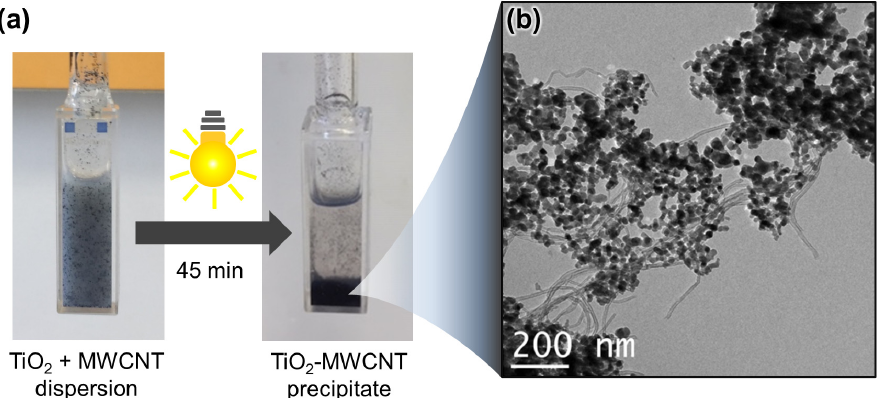
Figure 1. ( a ) Photoreactor before (left) and after (right) exposure to light; ( b ) TEM picture of TiO 2 /CNT aggregates.